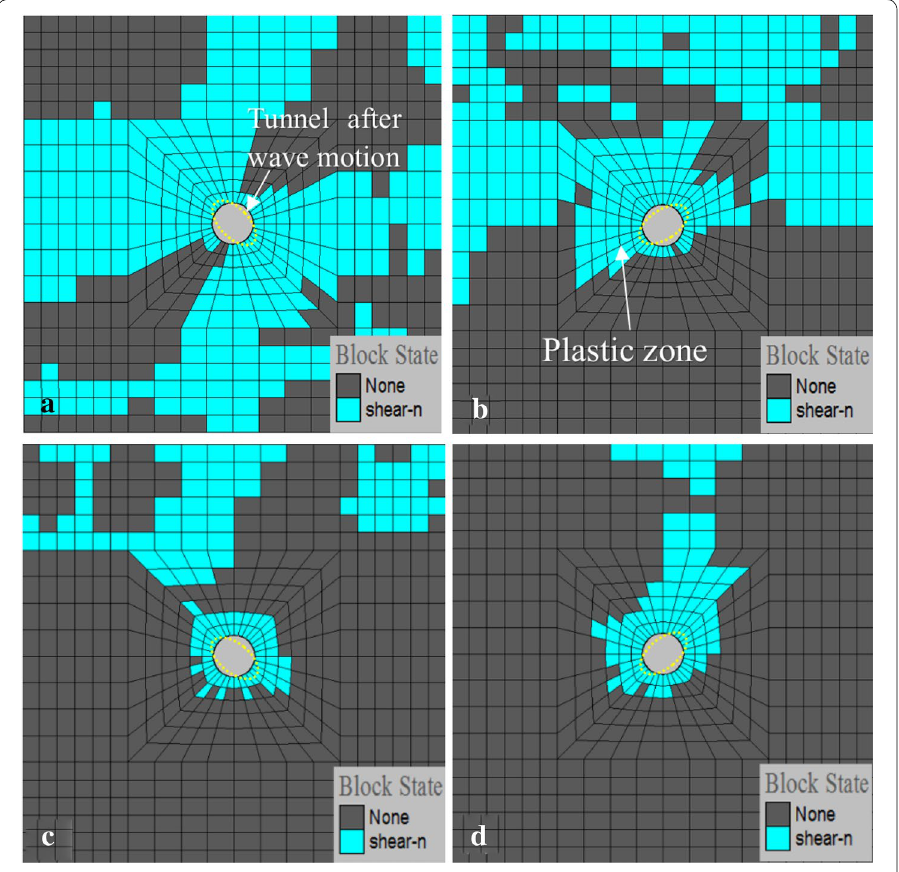
Fig. 14 Plastic zone size vs. time a 4 s, b 9 s, c 20 s, d 23